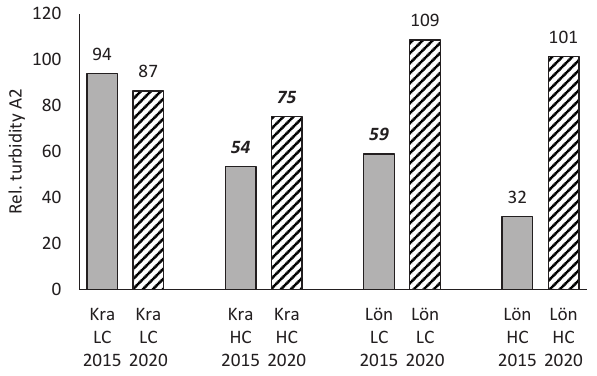
Fig. 6. Relative turbidity as a mean of the three structure liming treatments SL0.5– SL2 (applying 4, 8 and 16 t ha -1 structure lime, respectively), compared with the unlimed control (SL0), where SL0 = 100. Results from the second rainfall simulation on 2–5 mm aggregates of tilled soil collected one year (2015) and six years (2020) after structure liming in trials with low clay content (LC) and high clay content (HC) at Krageholm (Kra) and Lönhult (Lön). Values in bold italics indicate a significant difference compared with the unlimed